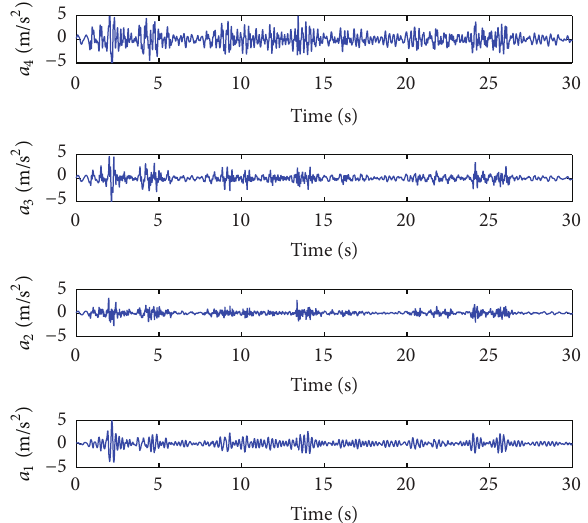
Figure 9: Measured acceleration responses for Case 3.